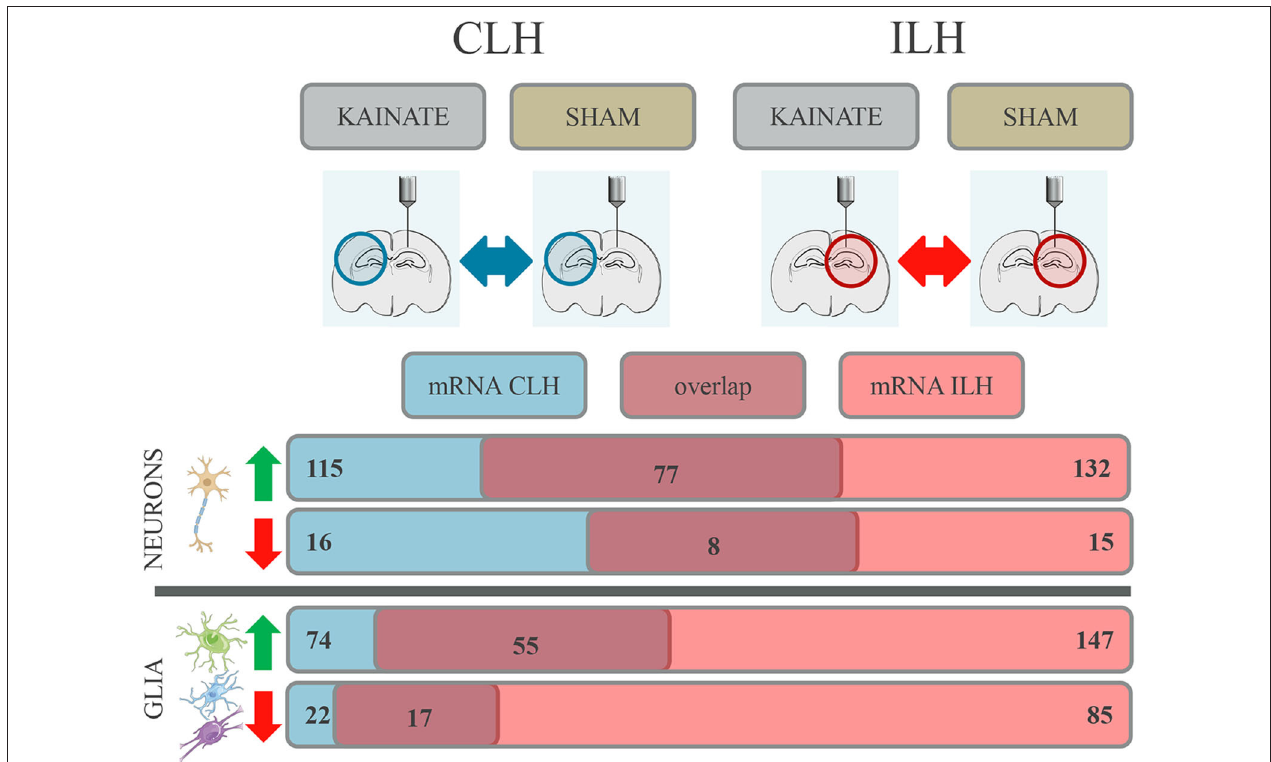
FIGURE 3 | Differential gene expression with overlap in the contralateral (CLH) and ipsilateral hippocampus (ILH) in both neurons and glia at 24h after kainate-induced status epilepticus. Number of genes in the neurons and glia showing differential expression in the CLH (numbers given in blue box ), in the ILH (numbers given in red box ), and in both hemispheres (numbers given in dark red box